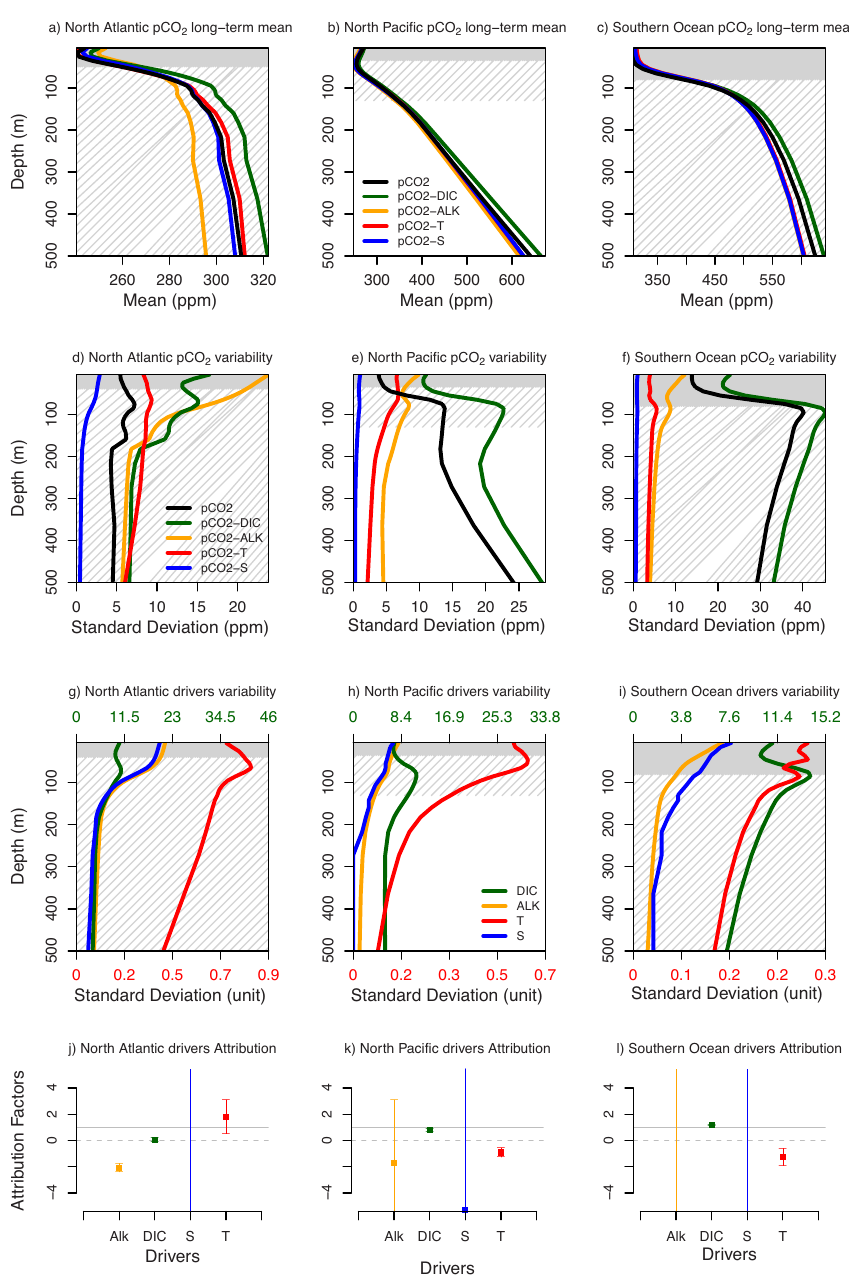
Fig. 10. Scaled spectral density of the five leading principal components of ocean carbon fluxes for (a) the North Atlantic (10 ◦ N–80 ◦ N), (b) the North Pacific (10 ◦ N–70 ◦ N) and (c) the Southern ocean( < 50 ◦ S). Dashed lines represent fitted AR1 theoretical spectrum according to the Yule-Walker estimation, while the linear dashed lines indicate the maximum of spectral density for each principal component. Confidence intervals at 95% of significance of the scaled spectral density maximum are indicated by vertical bars; they have been computed from a (scaled) χ 2